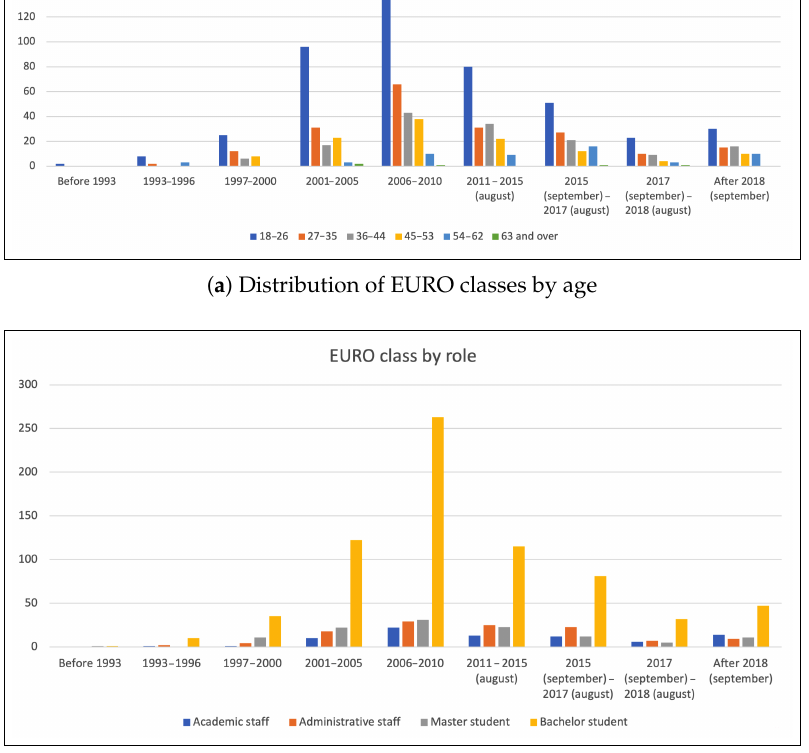
Figure 18. Distribution of EURO classes by age and role.